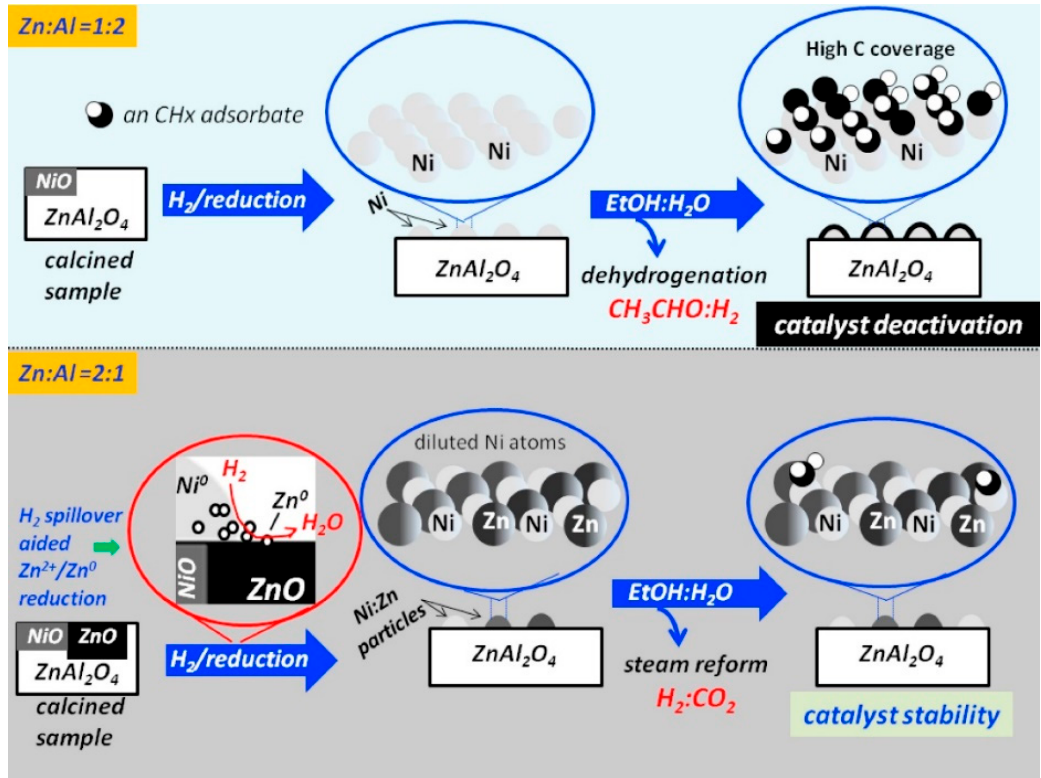
Figure 10. Phase transformation during reduction and reaction steps over Ni/ZnAl having two different Zn/Al molar ratios. Reprinted with permission from Ref. [98]. Copyright 2022